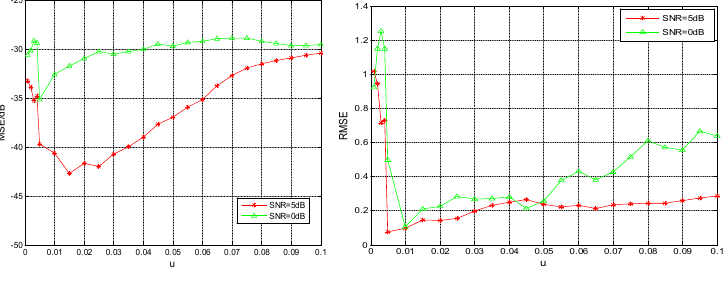
Fig. 3. MSE changes with u . Fig. 4. RMSE changes with u .